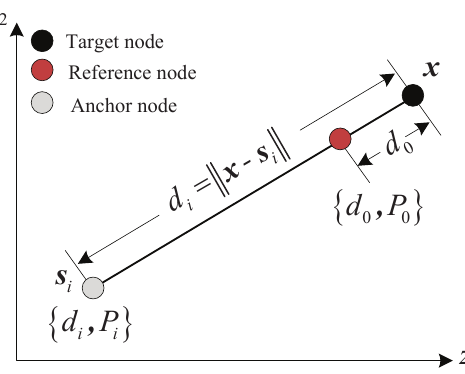
Figure 1. The i -th sensoring link in the underwater acoustic wireless sensor network (UWSN)